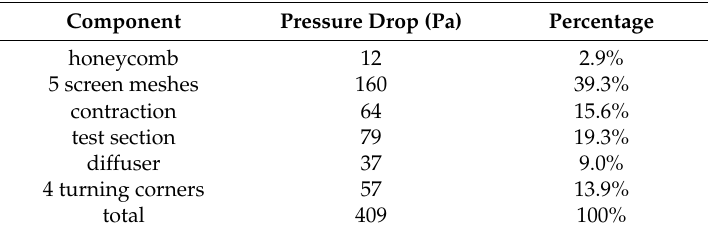
Table 4. Estimated pressure drops on components of investigated closed-loop wind tunnel (V ex = 60